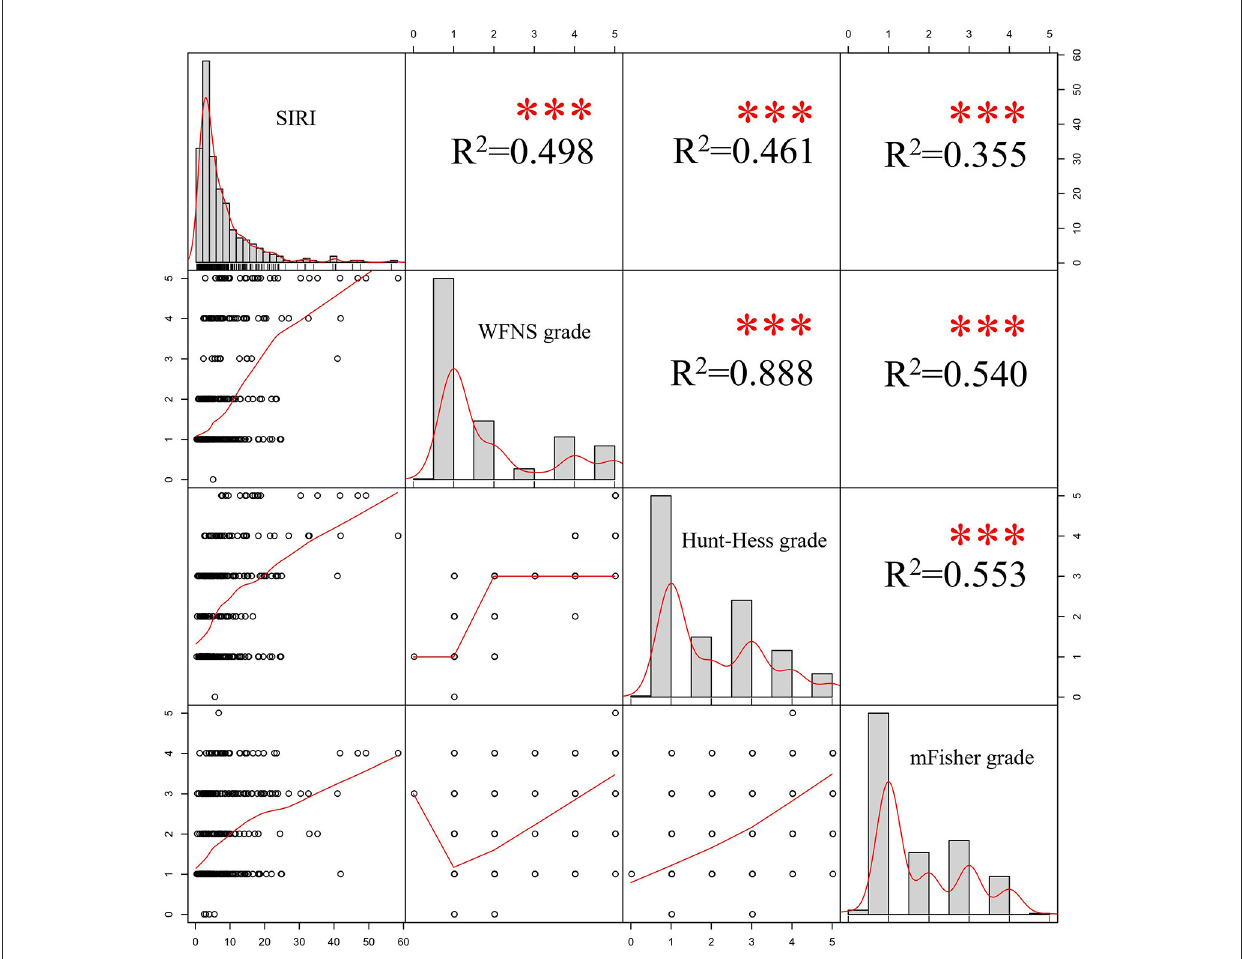
FIGURE4 Results of Pearson’s correlation analyses. SIRI, systemic inflammation response index; WFNS, World Federation of Neurosurgical Societies; mFisher, modified Fisher.